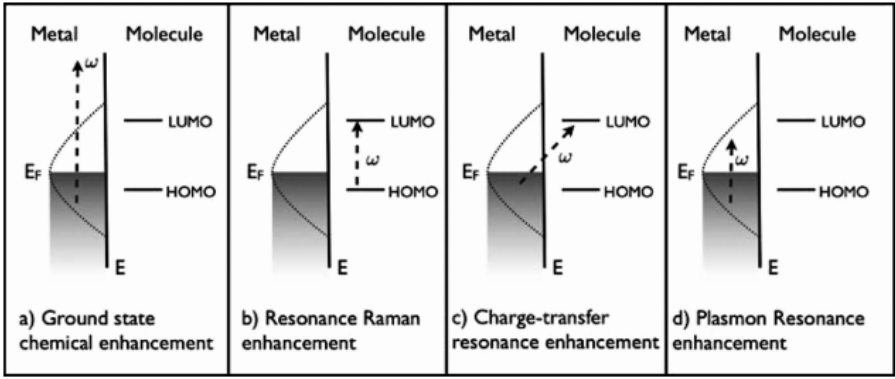
Figure 1. Illustration of the different types of enhancement mechanism. Reprinted with permission from ref. [10]. Copyright 2008 Royal Society of Chemistry. Chemical enhancement mechanism: ( a ) Diagram of the mechanism of ground state chemical enhancement. ( b ) Diagram of the mechanism of resonance Raman enhancement. ( c ) Diagram of the mechanism of Charge-trancsfer enhancement. ( d ) Diagram of the mechanism of plasmon resonance enhancement.